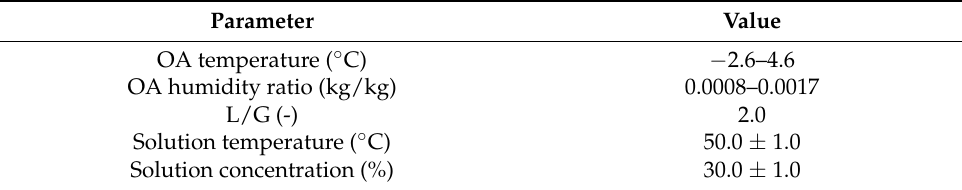
Table 3. Test conditions. L/G: liquid-to-gas